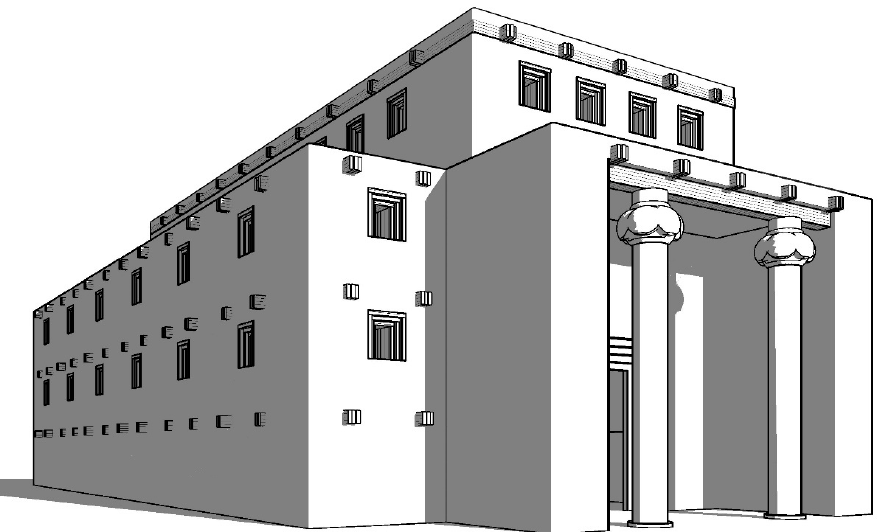
Figure 9. Isometric reconstruction of Solomon’s Temple based on our analysis of the text and relevant archaeological data.